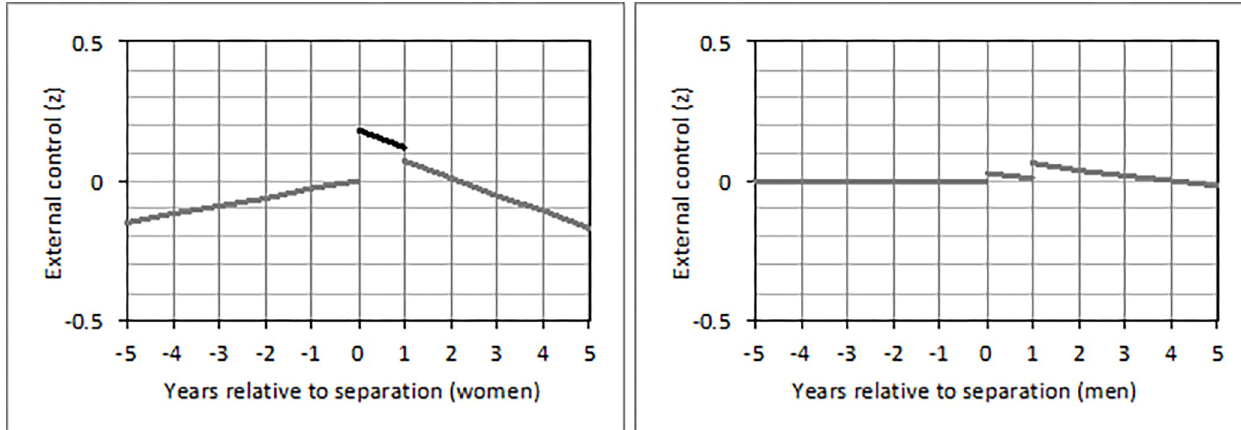
Fig 3. Changes of external control beliefs from five years before until five years after separation from a partner in (a) women and (b) men who experienced this loss between 1991 and 1999. Note . A detailed description of the figure can be found in Fig 1. The second line in (a) is marked in black because the short- term effect reached statistical significance ( p < .05) only in women but not in men.